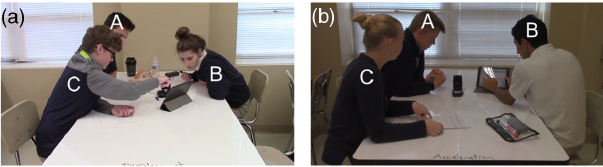
FIG. 7. Images of two contrasting groups working on the colliding crates activity from Liam ’ s classroom. Panel (a) shows students A and C being able to easily see the computer, while student B has to lean in to see the device. Panel (b) shows students A, B, and C all with a line of sight to the computer so that they can easily